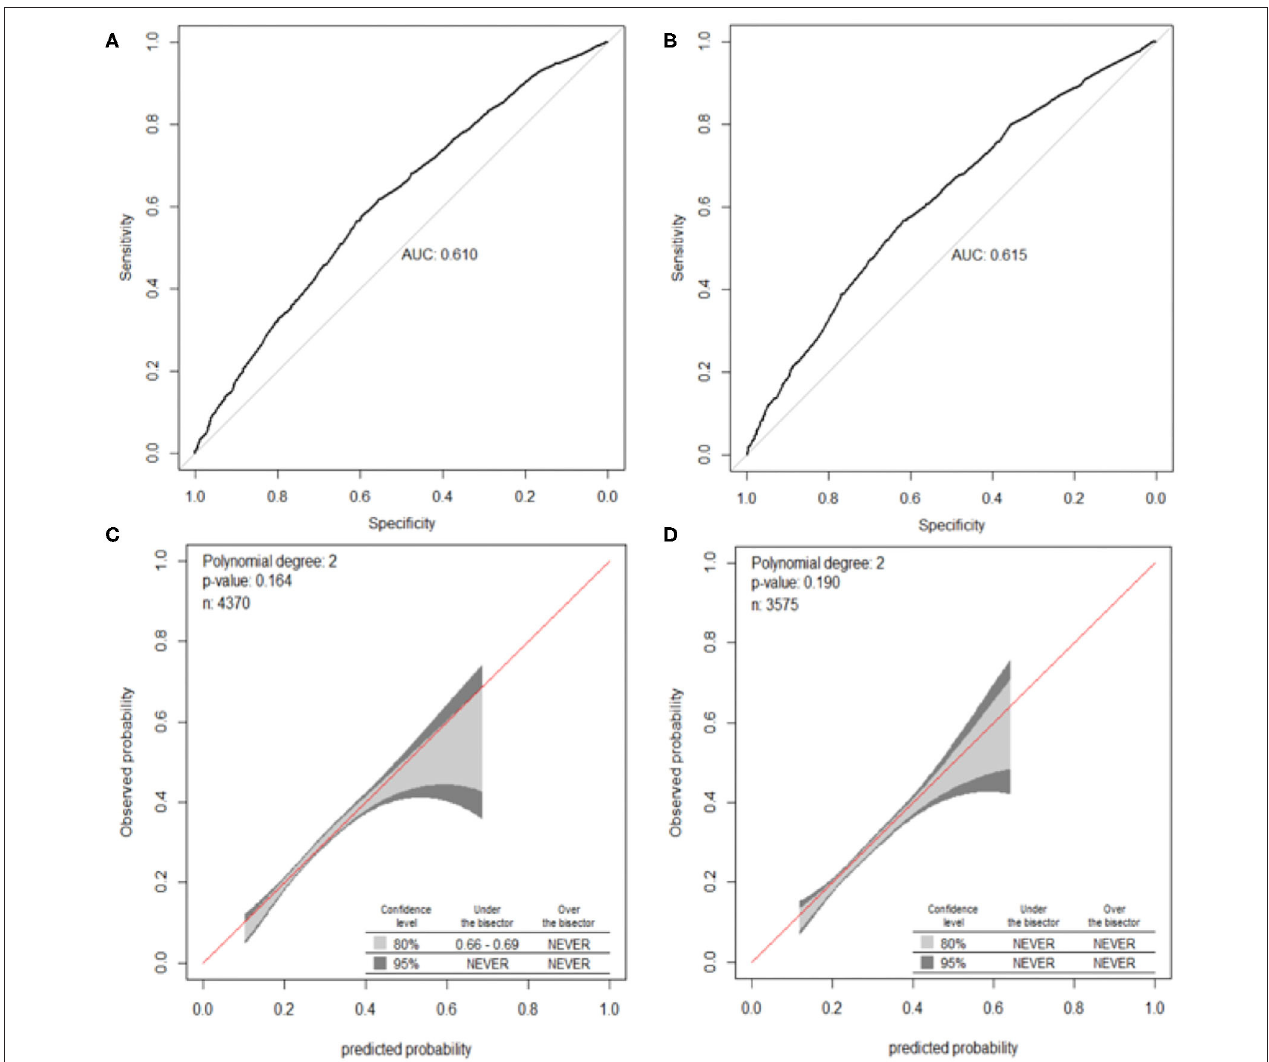
FIGURE 3 | ROC curves and calibration plots of the nomogram for OLGA any-stage. (A) ROC curve in the training cohort, (B) ROC curve in the validation cohort, (C) calibration plot in the training cohort, and (D) calibration plot in the validation cohort. OLGA, operative link for gastritis assessment; ROC, receiver operating characteristic curve; AUC, area under the